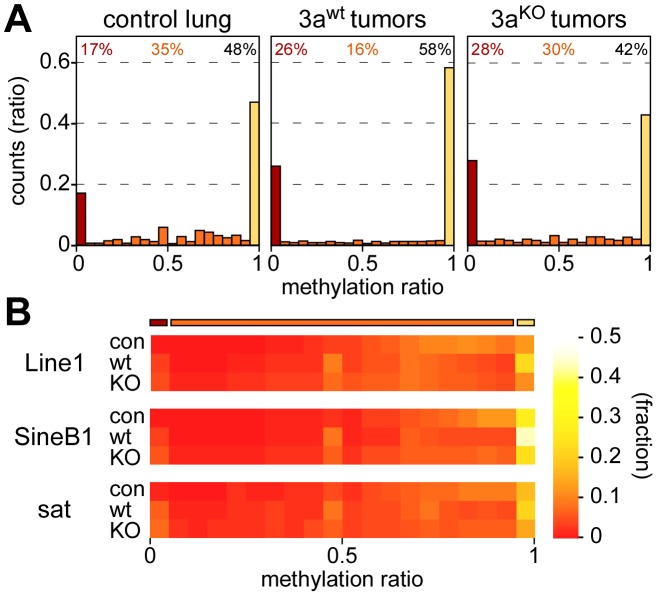
Methylation levels of CpGs and repetitive elements.(A) Methylation levels of individual CpGs in several tissue samples. Average methylation levels were determined for all covered CpG dinucleotides and then distributed into bins with increasing methylation ratios. Red bars indicate unmethylated CpG dinucleotides, orange bars partially methylated CpG dinucleotides and yellow bars completely methylated CpG dinucleotides. Percentages indicate the fractions of unmethylated (red), partially methylated (orange) and completely methylated (black) CpGs, respectively. (B) Color-coded histograms showing the distribution of repetitive element methylation in several tissue samples, as indicated. Average methylation levels were determined for all covered repeat elements and then distributed into bins with increasing methylation ratios.